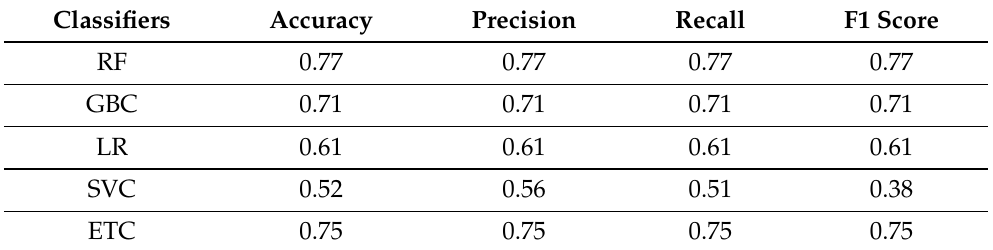
Table 12. Results of machine learning models using original features.